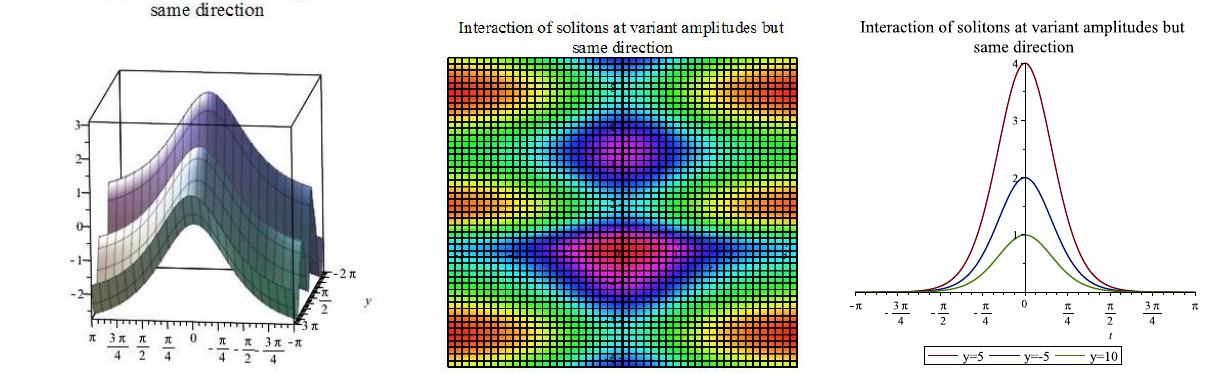
Figure 5. Wave profile depiction of soliton interaction with varying amplitudes but acting and propagating along the same direction where we have variable x = 0.